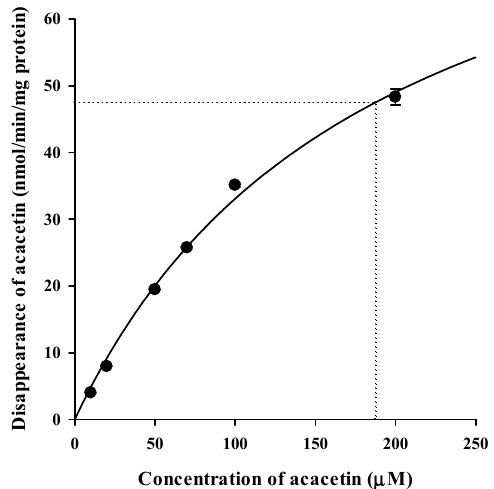
Figure 6. Concentration dependency for the disappearance of acacetin in RLM in the presence of NADPH and UDPGA/alamethicin. The bullet symbols and error bars represent the means and standard deviations, respectively ( n = 3). The solid lines represent the fitted nonlinear regression curves.